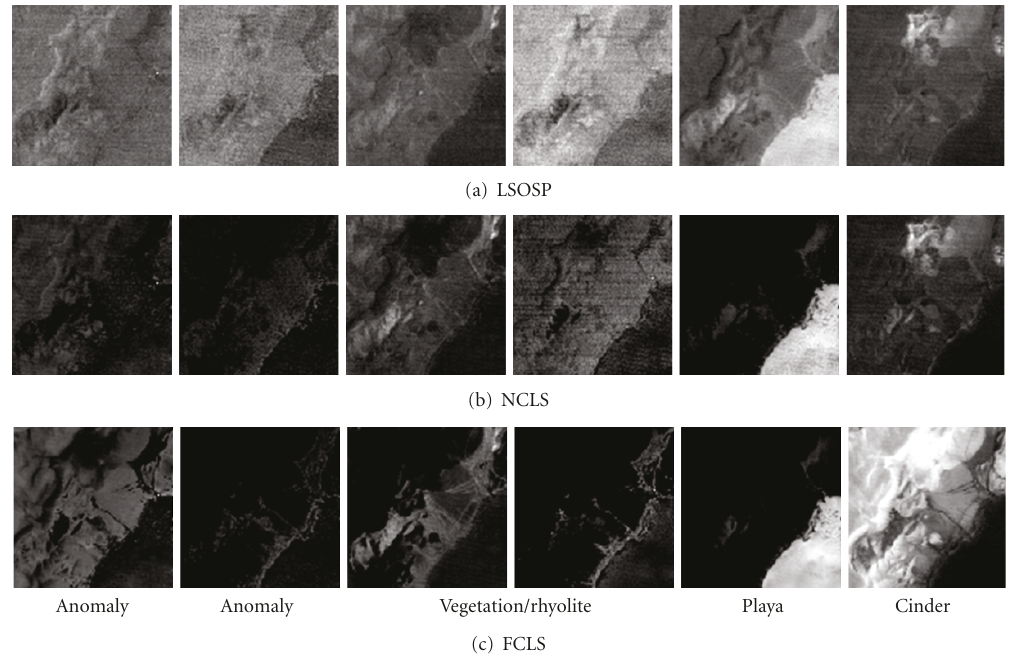
Figure 32: LSOSP, NCLS, and FCLS unmixed results using signatures of samples in Figure 31(d).